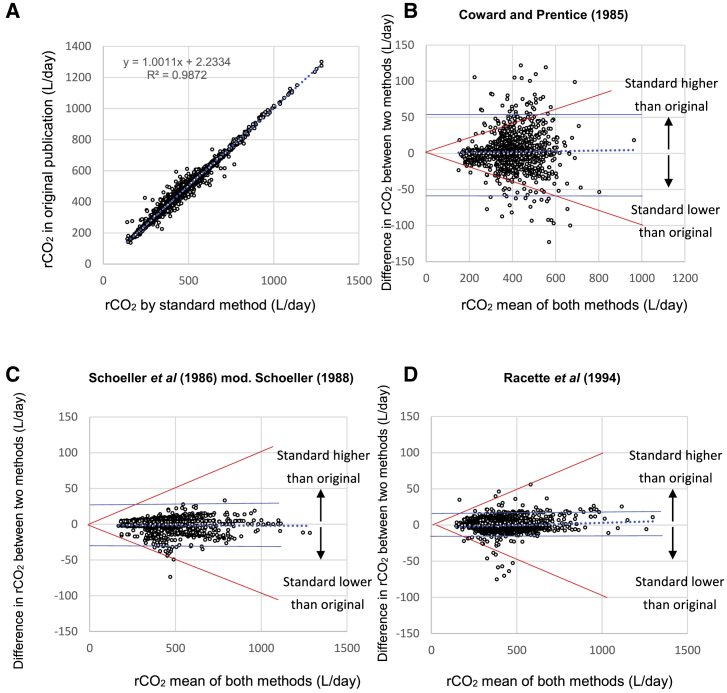
Comparison of published CO2 production by doubly labeled water to that by standard method(A) Relationship between CO2 production (L/d) for 5,756 individuals extracted from the original studies and the recalculated estimates using Equation 1.(B–D) Bland-Altman plots25 comparing the published rCO2 for studies using (B) the Coward and Prentice22 equation, (C) the Schoeller et al.15 A6 equation, and (D) the Racette et al.19 compared with the standard Equation 1 derived from Sagayama et al.20 In all plots, dotted line is average difference, and solid blue lines are plus and minus 2 SDs. The red lines define the boundary for plus and minus 10% difference between methods. Data refer to 5,756 adult individuals uploaded into the IAEA DLW database (v3.1).